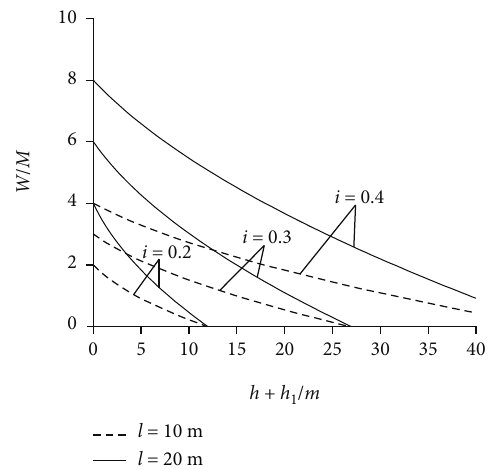
Figure 7: Relationship between the maximum subsidence w and the structure bearing thickness ( h + h 1